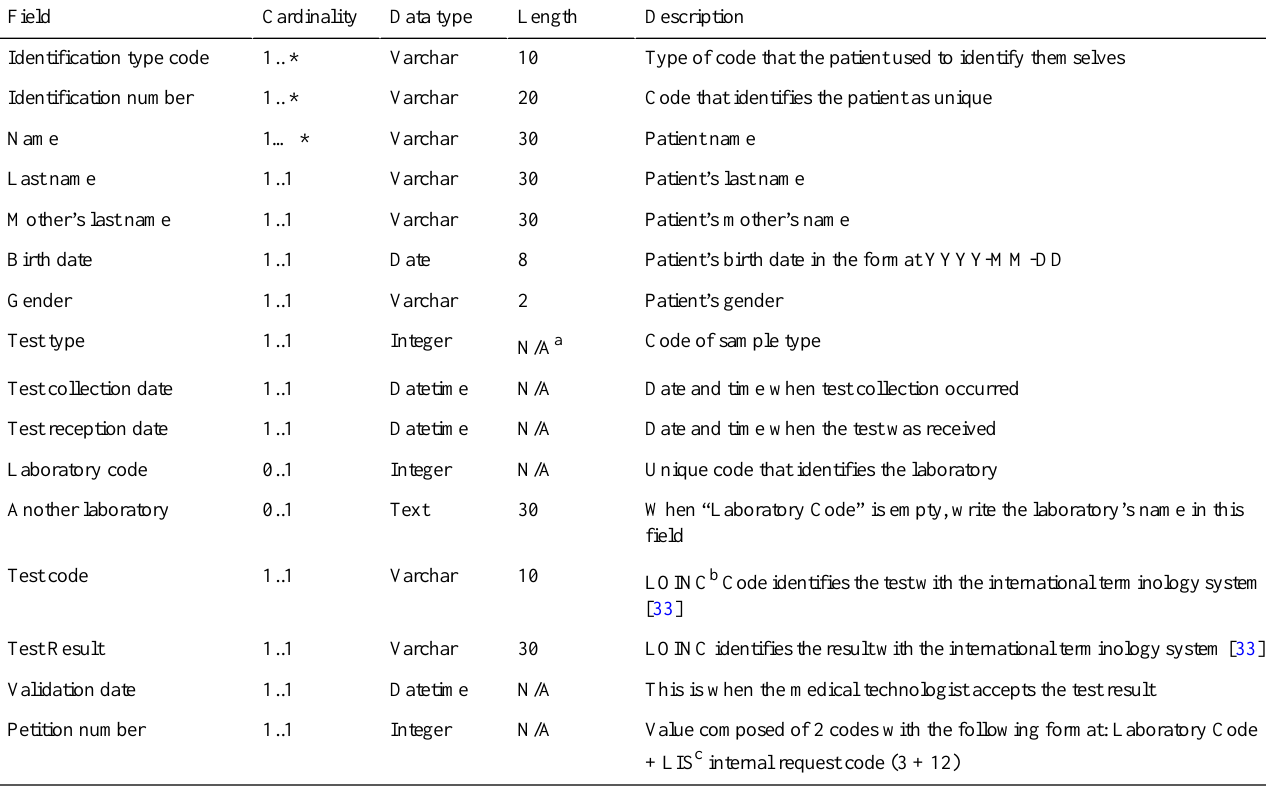
Table 1. Data set of laboratory polymerase chain reaction results. The minimum data set to build the polymerase chain reaction SARS-CoV-2 report. DescriptionLengthData